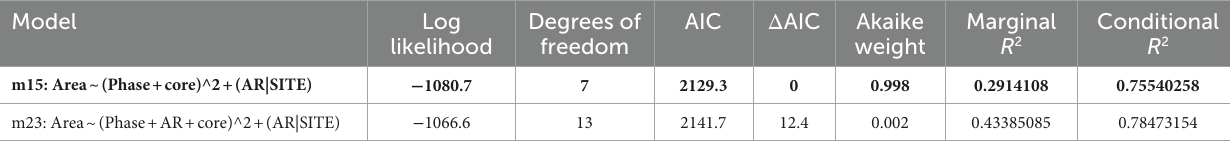
TABLE 3 Log likelihood, AIC and Akaike weights of all models with non-zero AIC weights for Globoconella puncticulata . Model